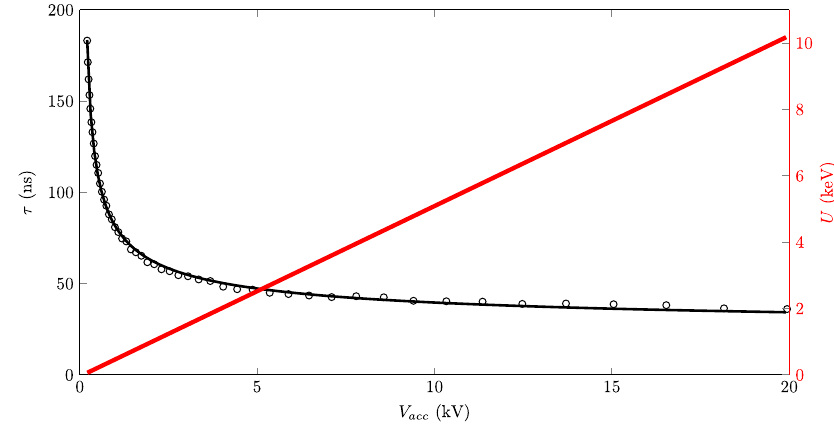
. The solid line is a fit using Eq. (5). The plot also shows the acc